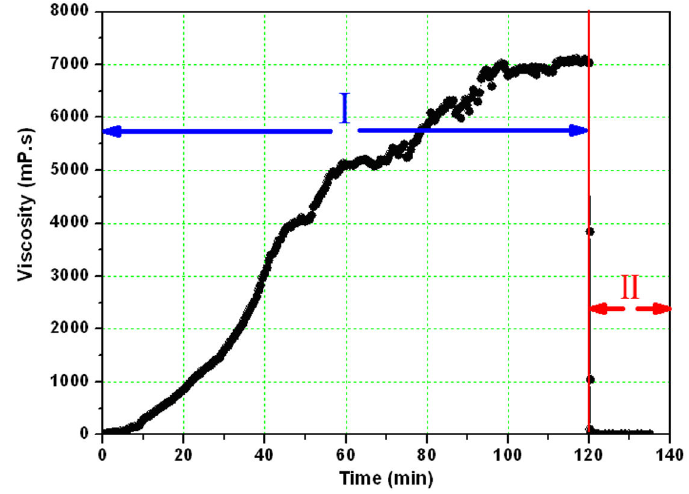
Figure 5. Viscosity changes in the whole preparation process. I: Viscosity changes during the bulk gel cross-linking reaction (formula: 0.4 % PAM + 1.6% cross-linker, the cross-linking time lasts from 0 min to 120 min) ; II: Viscosity changes during the DPG particle preparation process (the shearing time lasts from 120 min to 135 min).